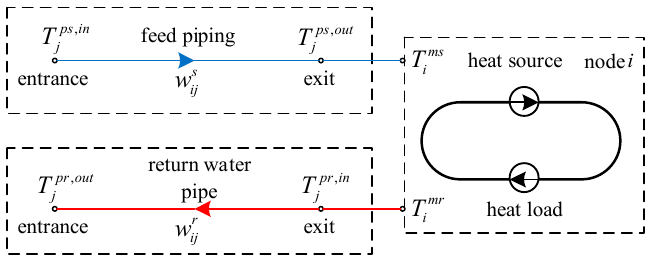
Figure 3. Thermodynamic subsystem model.